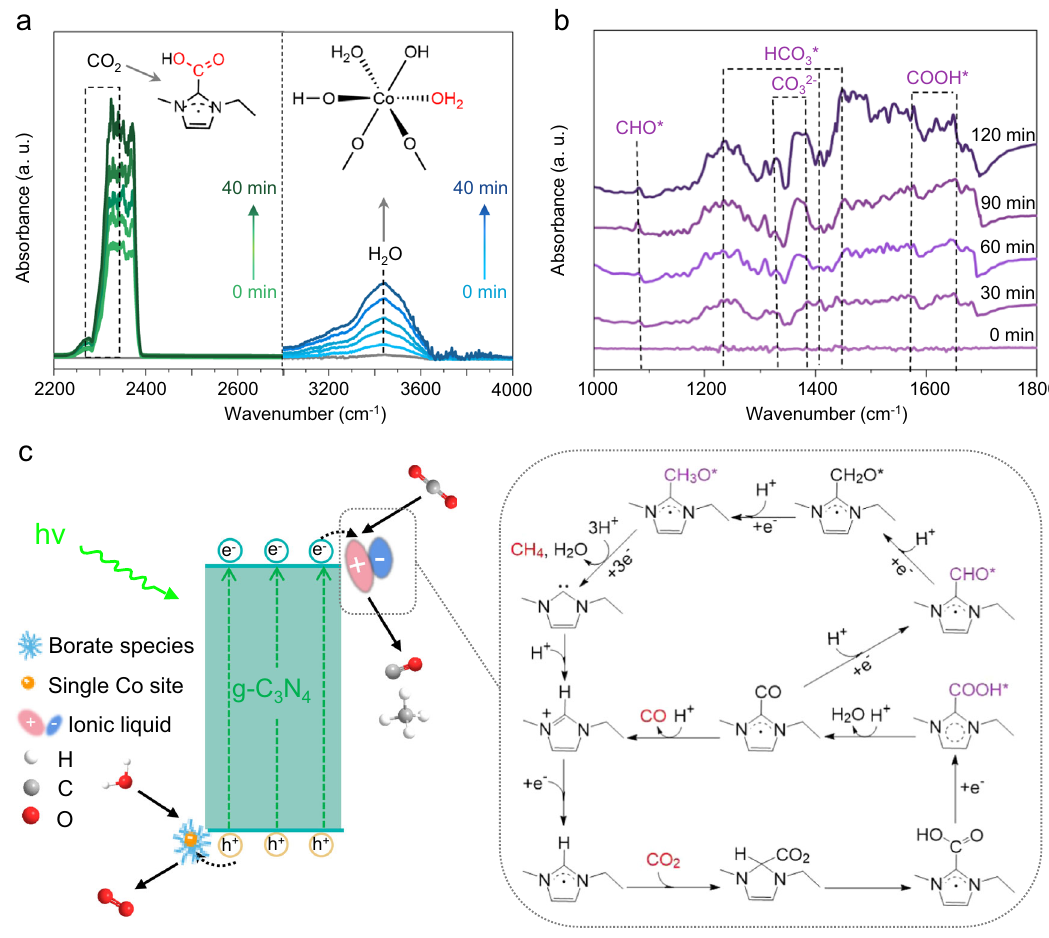
Fig. 5 | Mechanism for CO 2 photoreduction on IL/Co-bCN. a FTIR spectra for adsorption of gaseous mixture of CO 2 /H 2 O vapor on IL/bCN (left panel) and Co- bCN (right panel) in dark, respectively. b In situ FTIR spectra for the CO